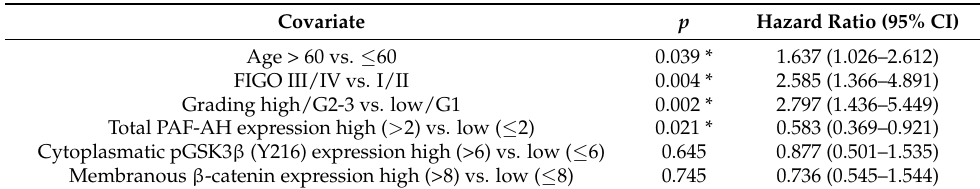
Table 5. Multivariate analysis confirmed the independency of tumoral PAF-AH expression as a positive prognostic factor for